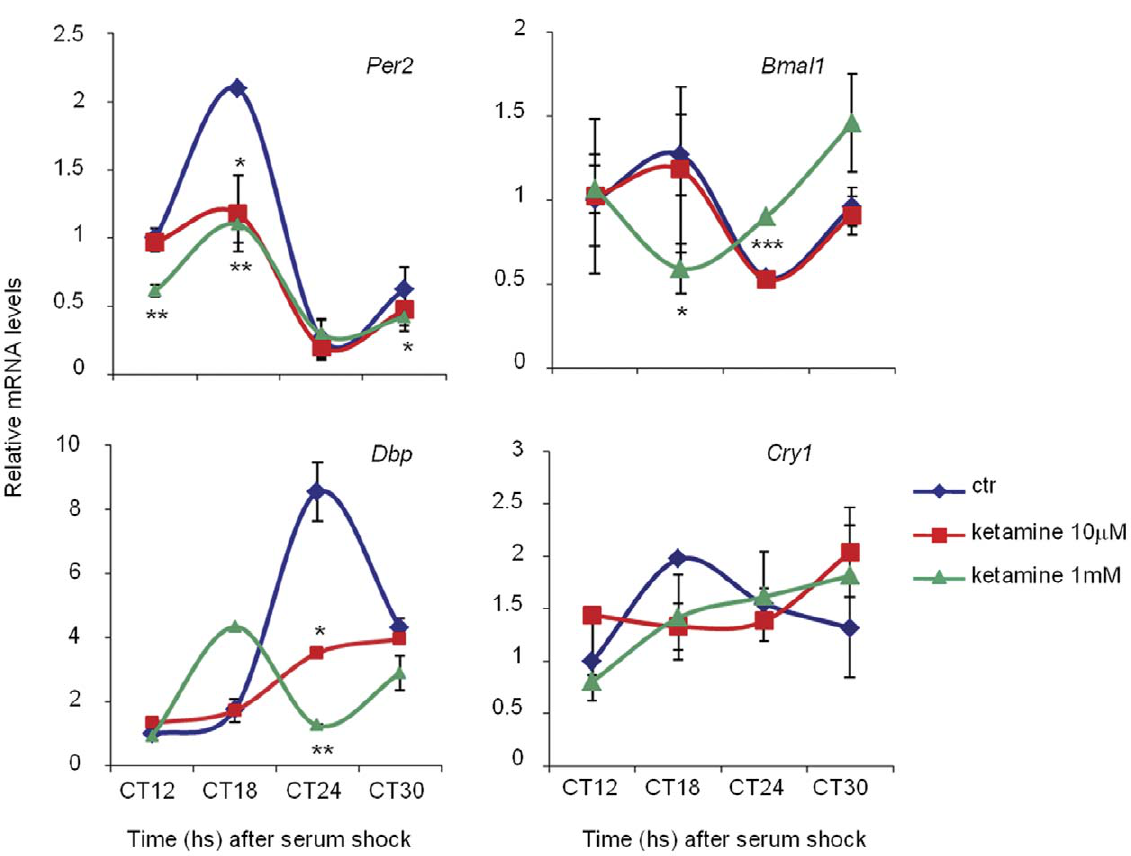
Figure 2. Altered circadian expression of clock genes and CCGs after ketamine treatment. Per2 , Dbp , Bmal1 and Cry1 mRNA expression profiles in WT MEFs, untreated or treated for 1 h with ketamine (10 mM and 1 mM) at circadian times CT11–12, CT17–18, CT 23–24, CT29–30 after serum shock, were analyzed by quantitative PCR. The values are relative to those of 18S mRNA levels at each CT (circadian time). Time 12 (CT12) value in untreated cells was set to 1. All values are the mean + / 2 SD (n=3); (*) p , 0.05, (**) p , 0.01, (***) p , 0.001.